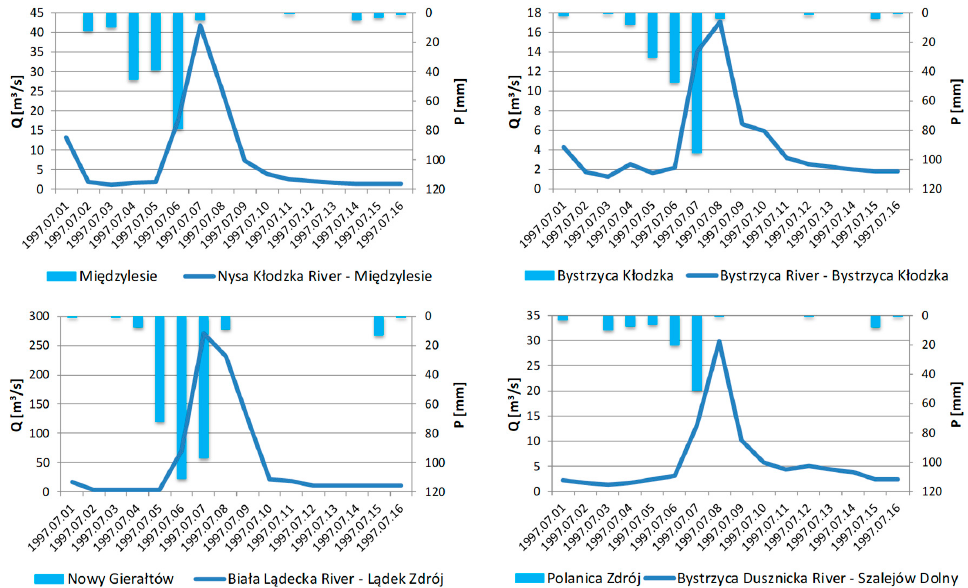
Figure 3. Course of daily discharge (m 3 s − 1 ) (blue line, left axis scale) and daily precipitation totals (mm) (light blue bars, right axis scale) in exemplary locations during flood in the K ł odzko Valley in